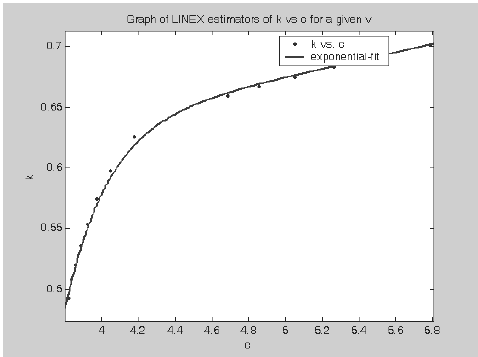
Figure 4 – Graph of LINEX estimators of k vs. c for a given v